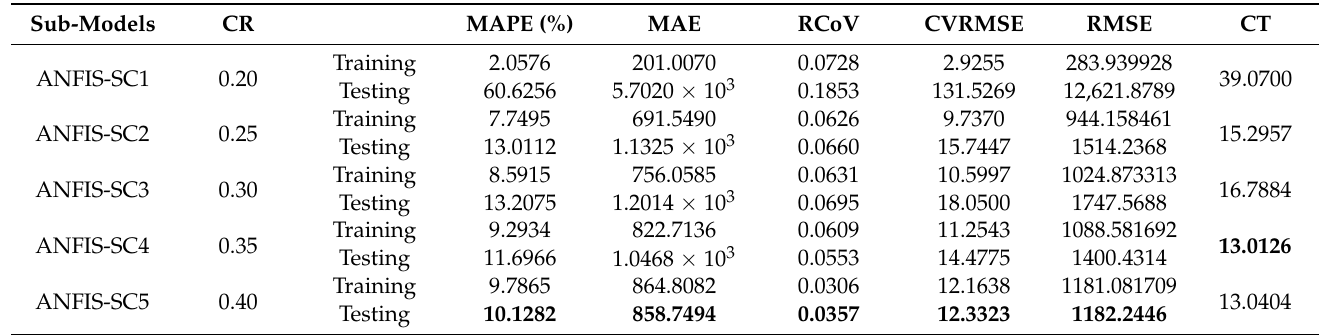
Table 5. Performance analysis for ANFIS-SC models.